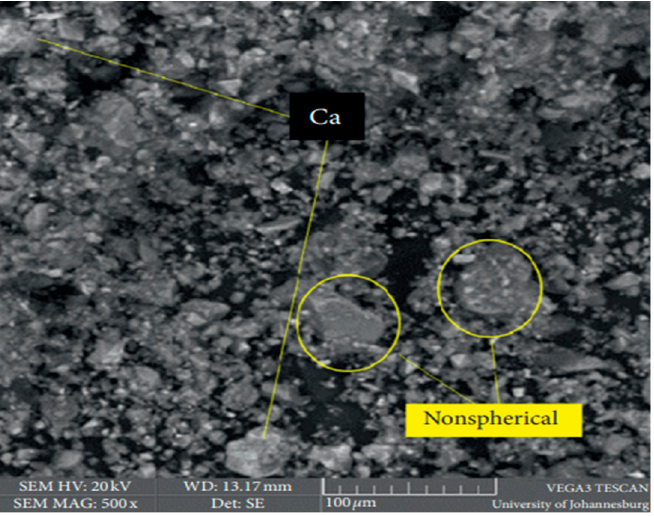
Figure 10. SEM image of BOFS [111].